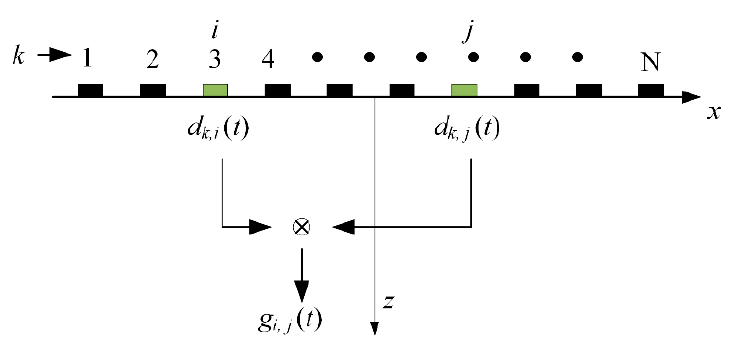
Figure 3. Green’s function retrieval using ultrasonic phased array.